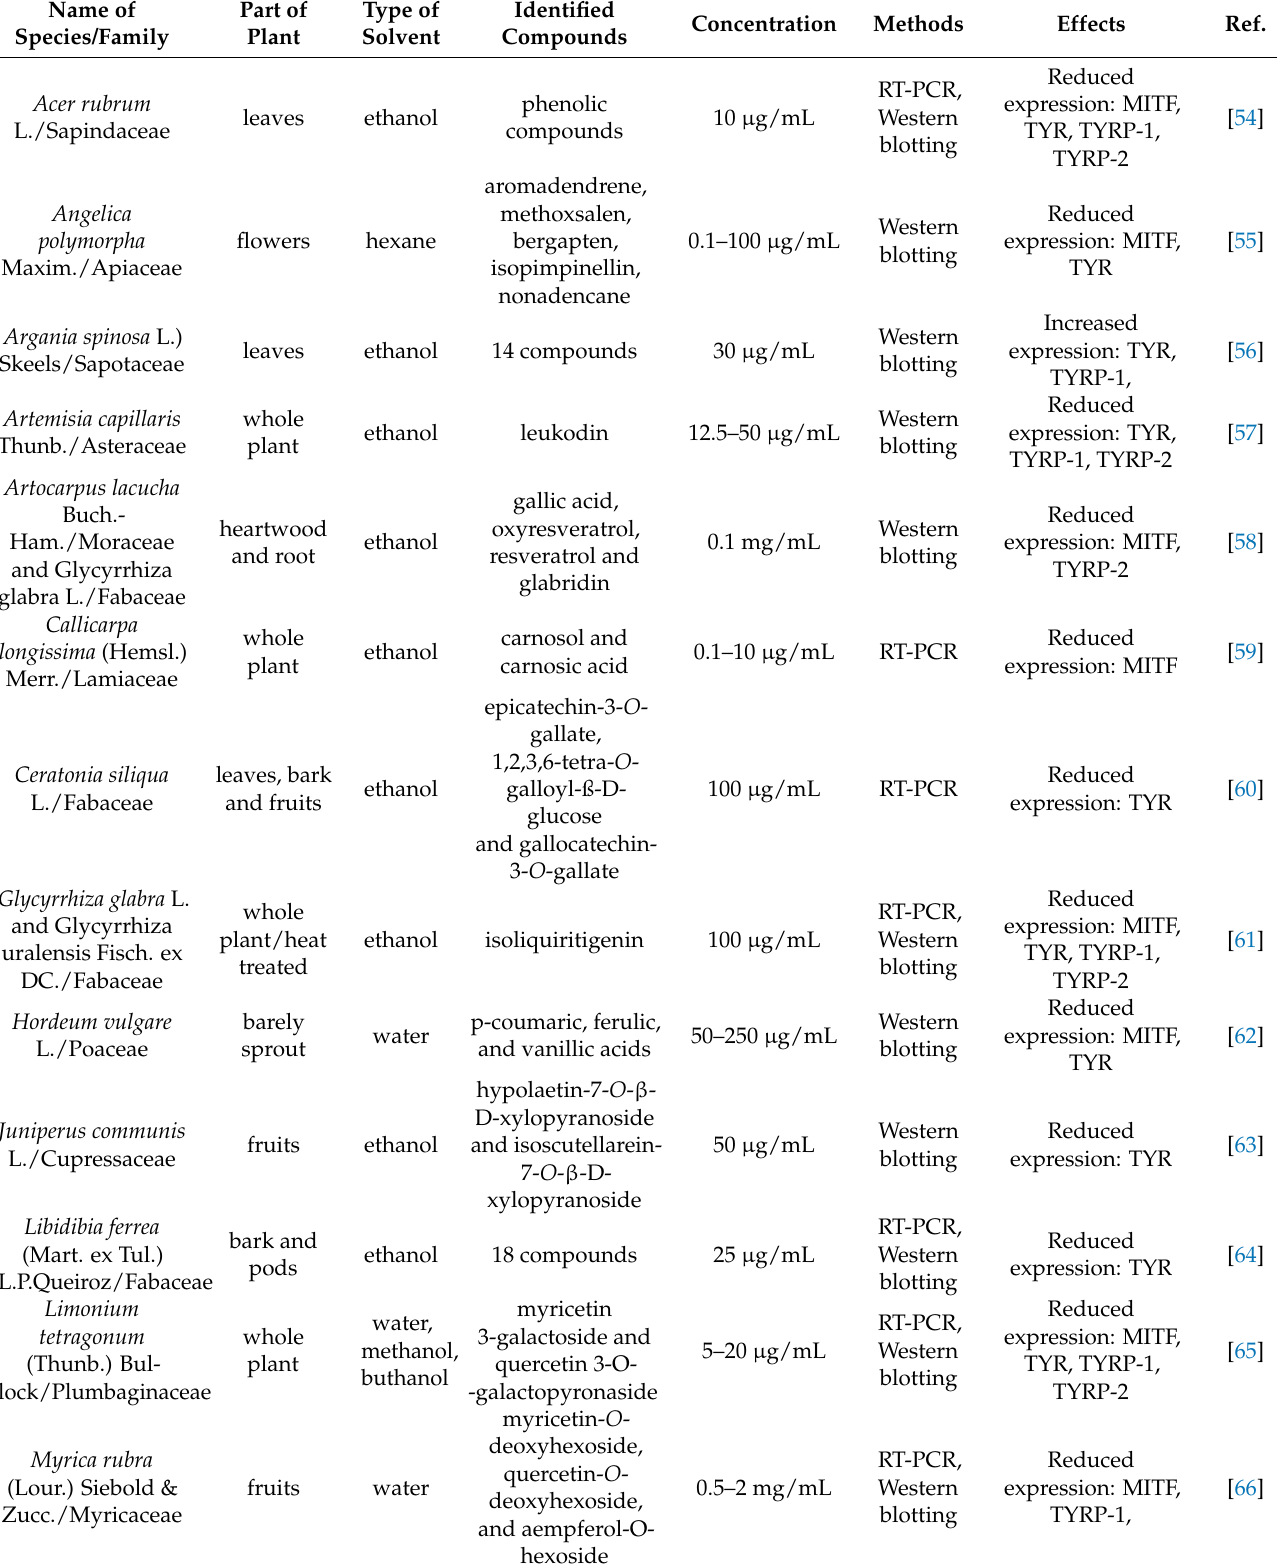
Table 2. Modulation on gene expression related to melanogenesis in B16 melanoma cells by plant extracts with identified